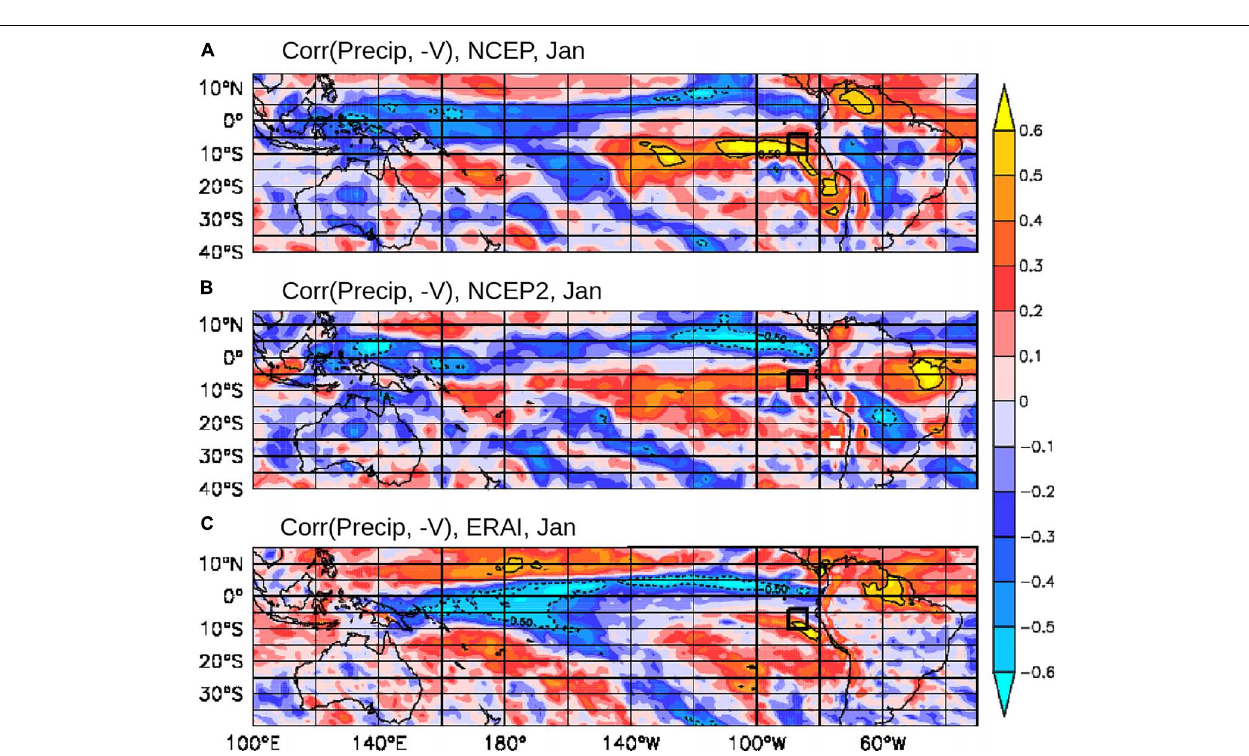
FIGURE 11 | March 2017 SST difference (in ◦ C) between the control run (CR) and sensitivity runs: (A) CR-Wclim and (B) CR-KWclim.